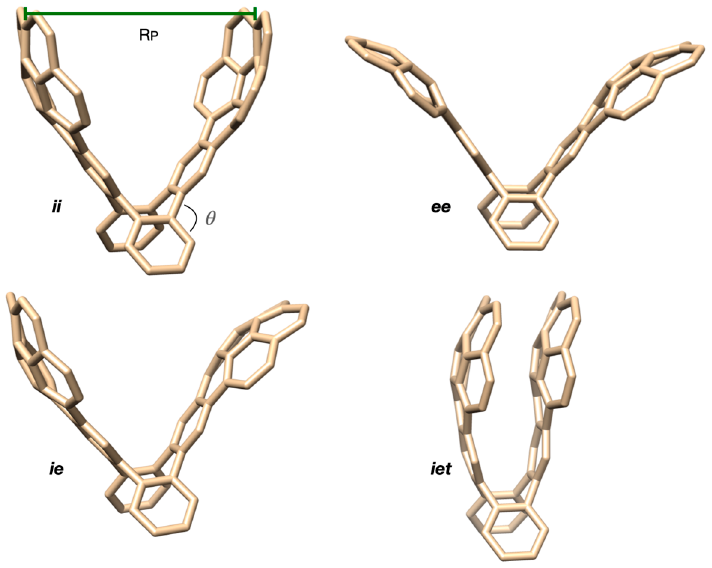
Figure 2. The structures of the four conformers of the corannulene pincer considered in this